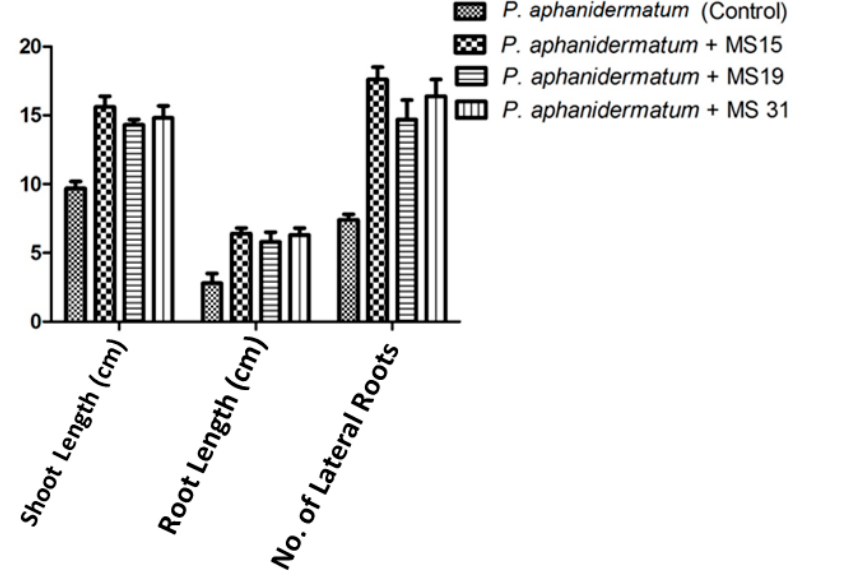
Figure 5. Effects of G. max seed treatment with the pathogenic P. aphanidermatum and three isolates of P. oligandrum (MS15, MS19, and MS31) on growth seed parameters. (Data are means of (3) replicates; values are significantly compared with control at p ≤ 0.05).